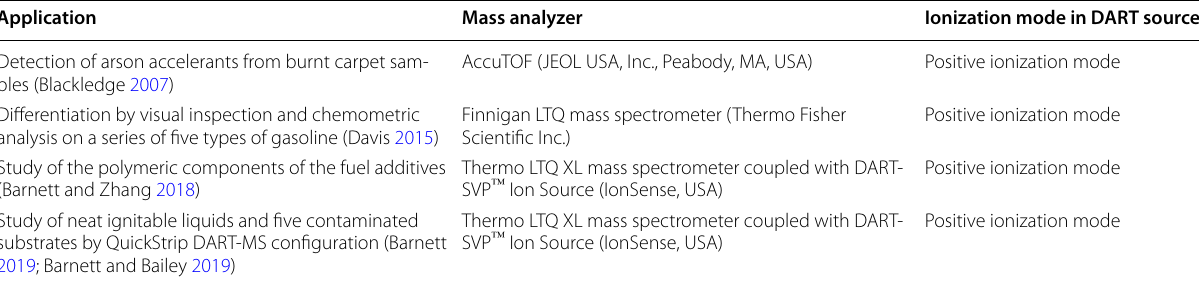
Table 9 Applications of various fire debris, ignitable liquids, and flammable solvents along with the type of mass analyzer used for their analysis